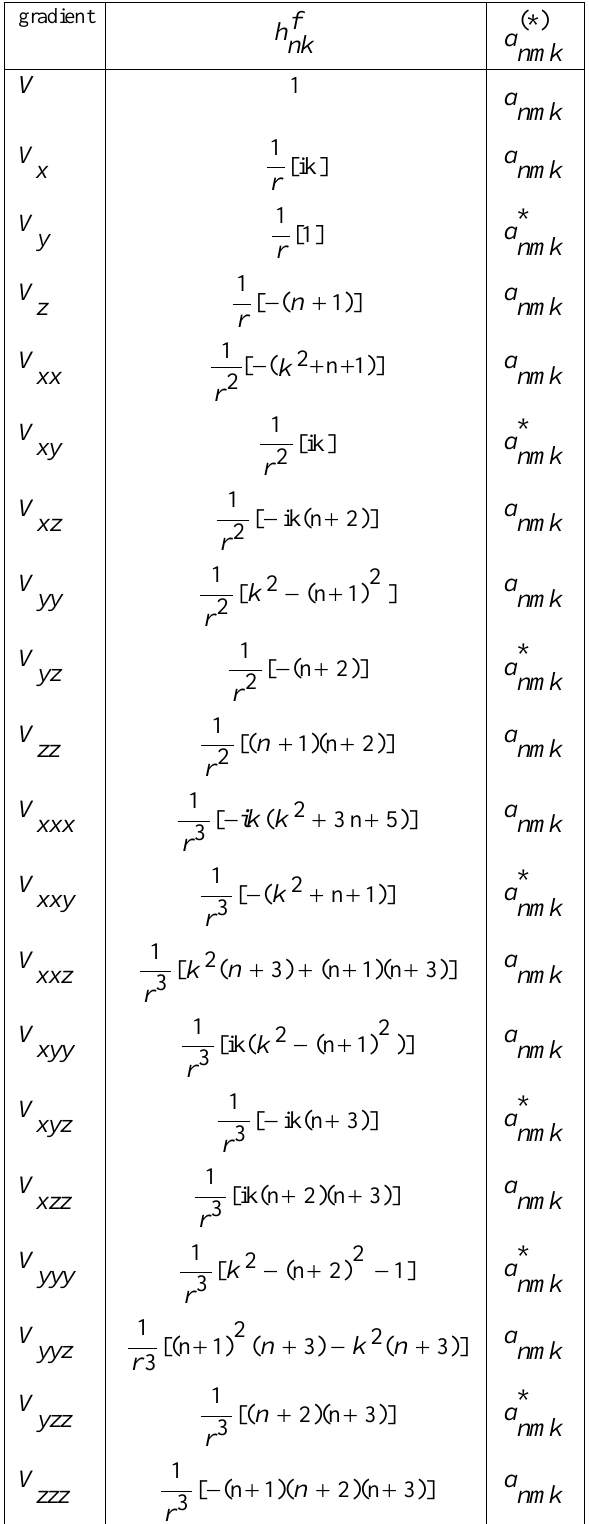
Table 1. The spectral transfers of the first-, second- and third- order gradients of a scalar field in LNOF